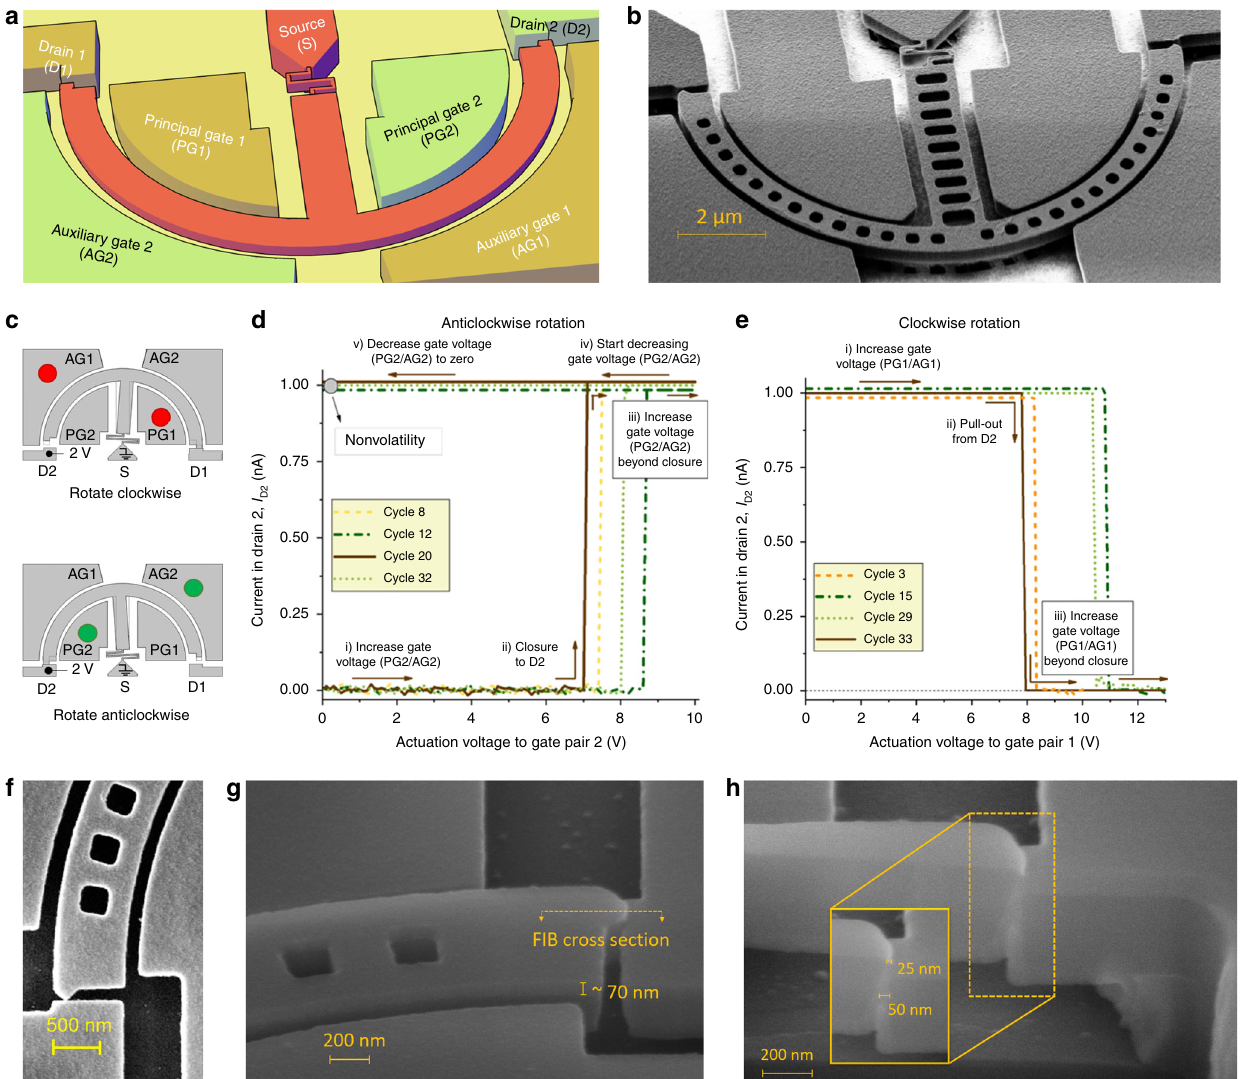
Fig. 1 Moment-driven relay with in-plane, quad-gate architecture. a Sketch and b micrograph of bistable nanorelay with a serpentine hinge, 120 nm gate- to-beam airgap, 100 nm rest-state contact gap and 80 nm hinge width. c Actuation patterns to switch relay with positive hinge offset (i.e. hinge anchor point above baseline diameter of beam semicircle) in the experiments conducted at high-temperature in a vacuum ambient. The coloured circles indicate connection of source measurement units; top (red) is used to rotate clockwise, while bottom (green) is used to rotate anticlockwise. d , e Examples of anticlockwise and clockwise rotation cycles at 200 °C of a nano relay with positive hinge offset 0.4 μ m, where a dc bias is applied to D2, causing a current I D2 to fl ow through it and the beam (source, S) on switch closure. Thus, for anticlockwise rotations, closure is indicated by the sudden increase in I D2 ; for clockwise rotations pull-out from D2 is monitored, indicated by the sudden decrease in I D2 . The beam electrode remains in contact with one of the drains after actuation voltages are decreased to zero. In clockwise rotations the actuation electrostatic force needs to overcome adhesion forces, as well as electrostatic forces resulting from the drain-source bias, resulting in a higher pull-out voltage. f Close-up of beam electrode in contact with D2, showing near constant inner and outer actuation airgaps. g Close up of tip in contact with D1 showing a layer of Ti on top. h Sectioned view of g . The total sidewall thickness across both contacting surfaces vary from ~25 nm at top to ~50 nm at